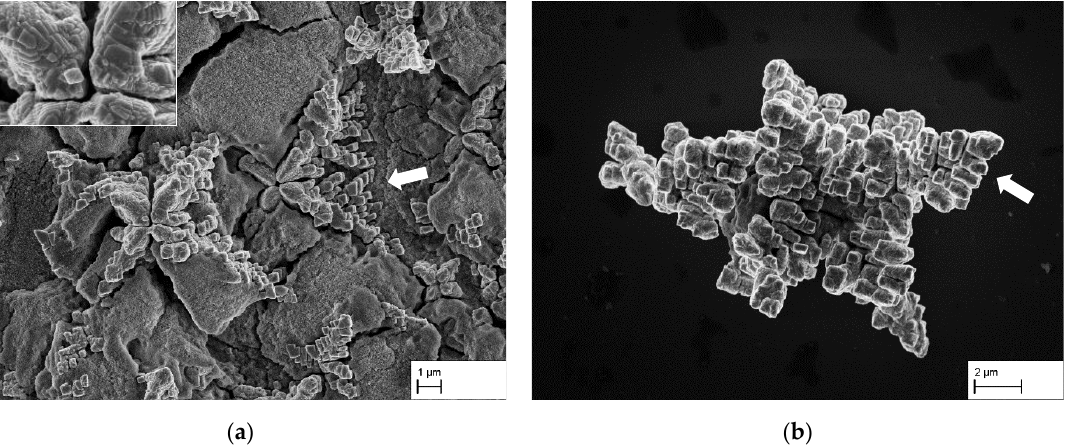
Figure 4. ( a ) Half octodendrites in deeply etched specimen cooled to 1150 °C. Inner regions are covered with steps caused by interfacial dislocations and with little cubic characteristics. These steps can be seen in the three times magnified image detail. ( b ) Extracted particle from specimen cooled to 1100 °C with cube-like outgrowth at the outer regions. In both pictures, white arrows exemplarily indicate those outgrowths.